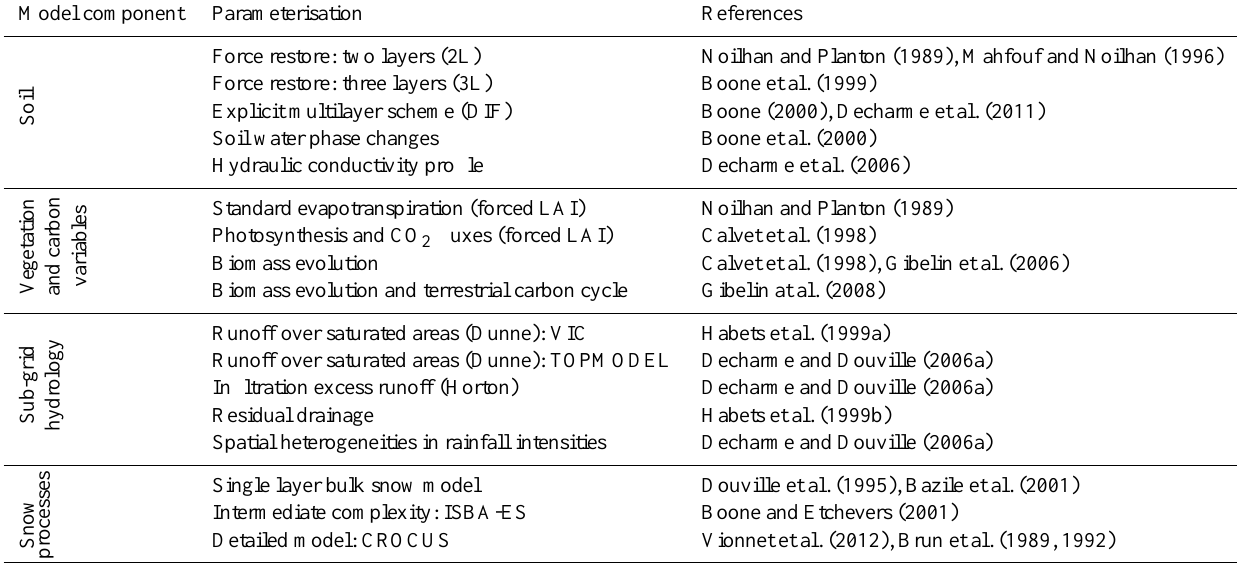
Table 2. Summary of the main parameterizations available in ISBA. Model